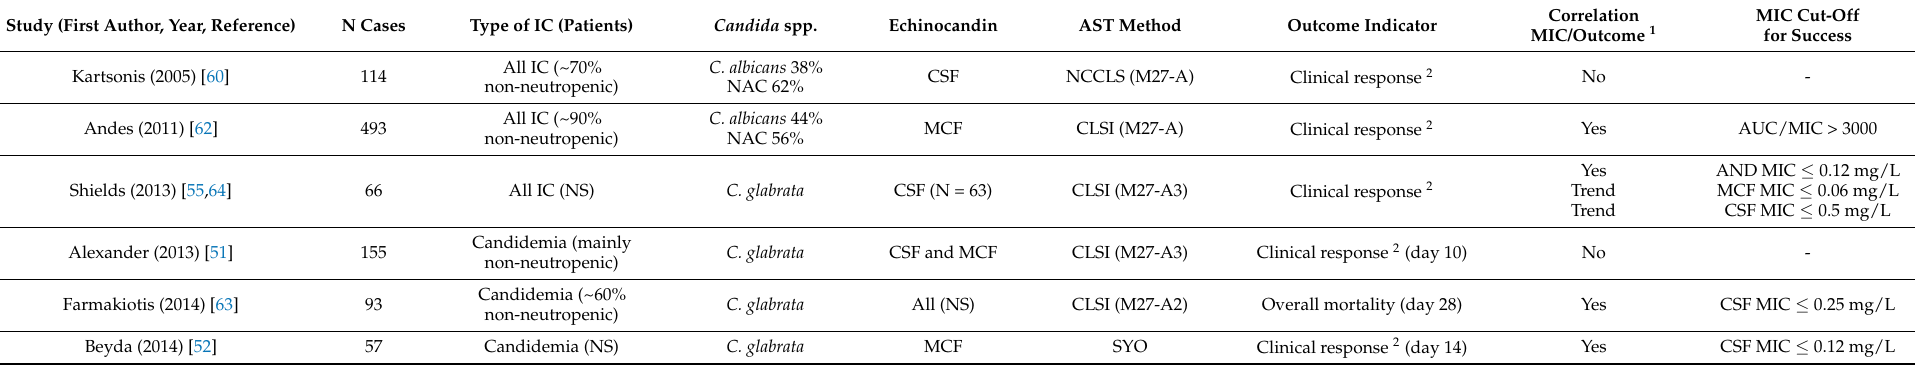
Table 3. Clinical studies correlating echinocandin minimal inhibitory concentrations (MIC) and outcome of invasive candidiasis